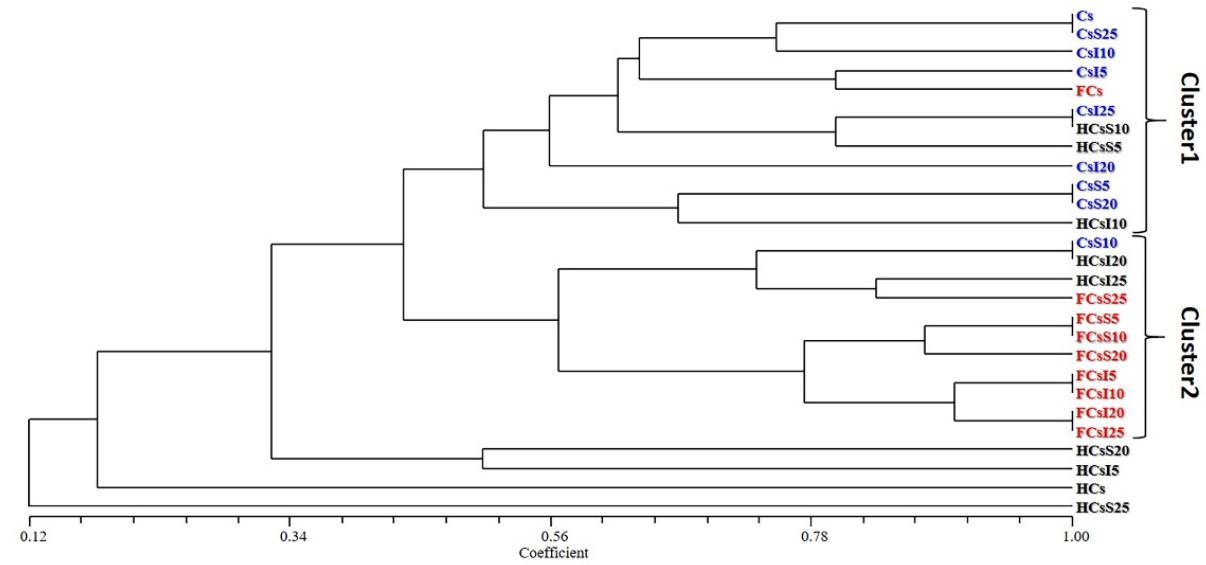
Figure 1. Hierarchical clustering dendrogram plotted from the cluster analysis. Cs, rearing substrate composed of 100% coffee silverskin; CsS5, CsS10, CsS20, CsS25 and CsI5, CsI10, CsI20, CsI25, rearing substrates supplemented with 5%, 10%, 20%, and 25% Schizochytrium limacinum and Isochrysis galbana , respectively; HCsS5, HCsS10, HCsS20, HCsS25 and HCsI5, HCsI10, HCsI20, HCsI25, Hermetia illucens larvae reared on the corresponding substrates; FCsS5, FCsS10, FCsS20, FCsS25 and FCsI5, FCsI10, FCsI20, FCsI25, frass collected from the H. illucens larvae reared on the corresponding substrates. Color-coding: feeding substrates (blue), H. illucens larvae (black), and frass